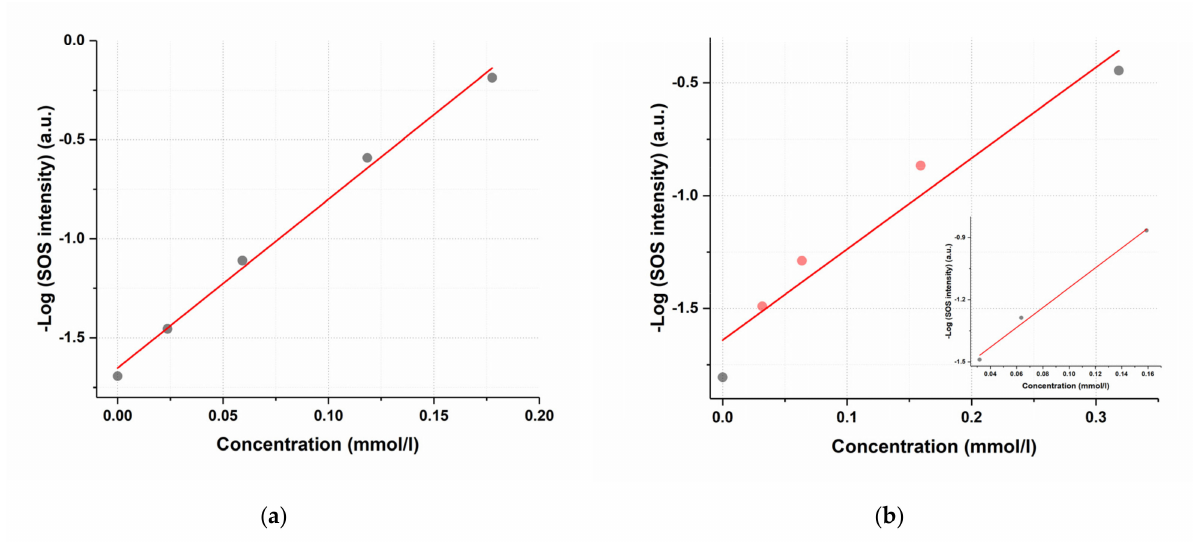
Figure 9. Linearized dependences of the humic complex second-order scattering signal on the concentration of the dissolved preparation: ( a ) for mangiferin (R = 0.997); ( b ) for favipiravir (R = 0.972). The insert in Figure 9b shows the analytical area of the linear dependence for favipiravir– 0.03–0.16